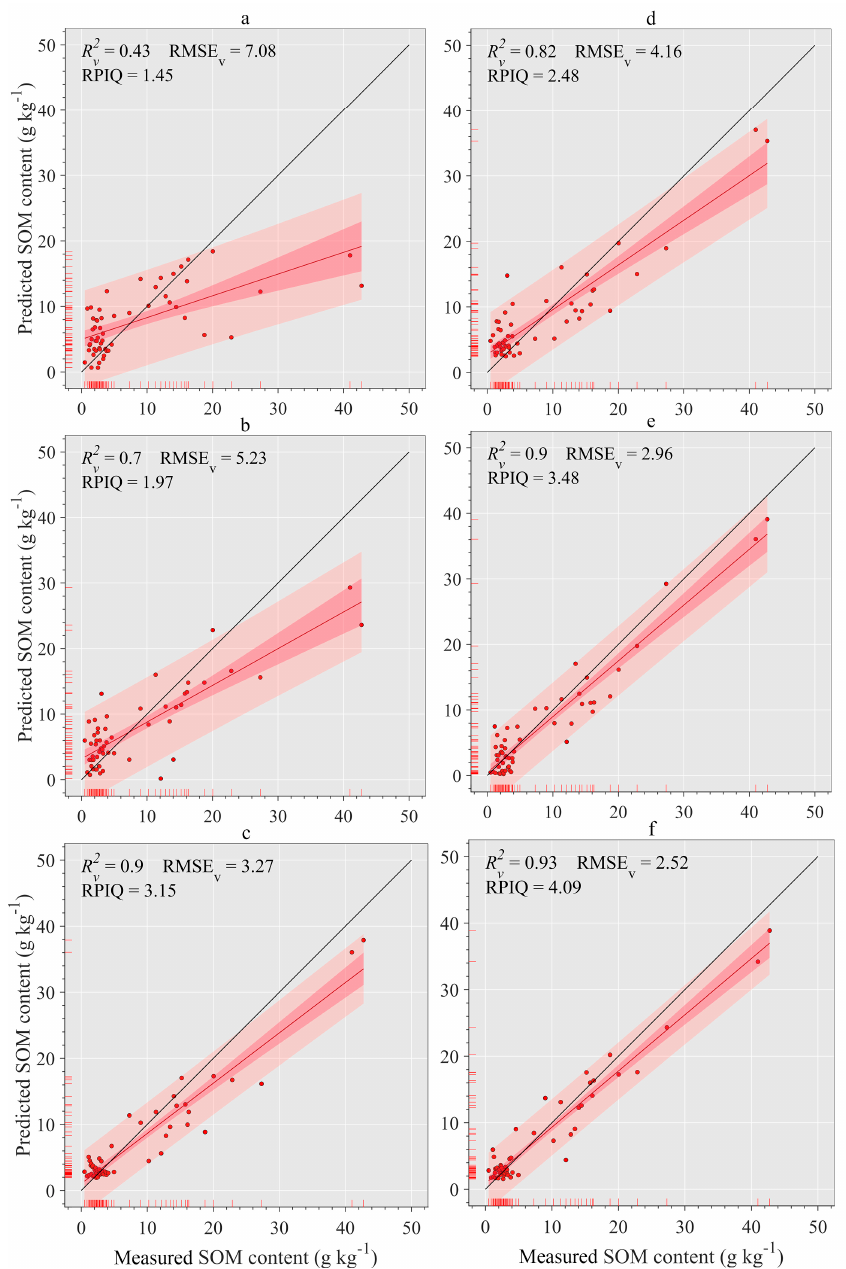
Figure 11. Comparison of measured versus predicted SOM content ( n = 56) based on the RF model with various modeling strategies. The salmon area (relatively wide area) and crimson area (relatively narrow area) cover the predicted SOM data and its fitting line with 95% probability, respectively. Red and blue lines represent the fitting line and 1:1 line between the measured and predicted SOM content,